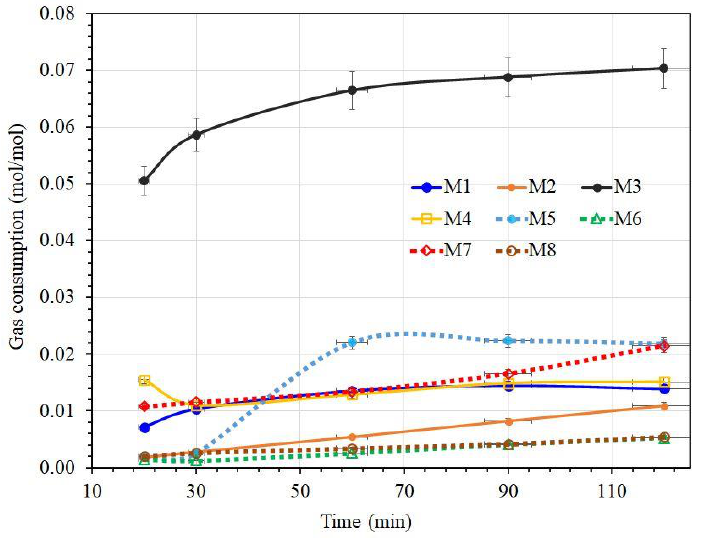
Figure 6. Total CH₄ gas consumption in two different liquids (DIW and seawater) with and without